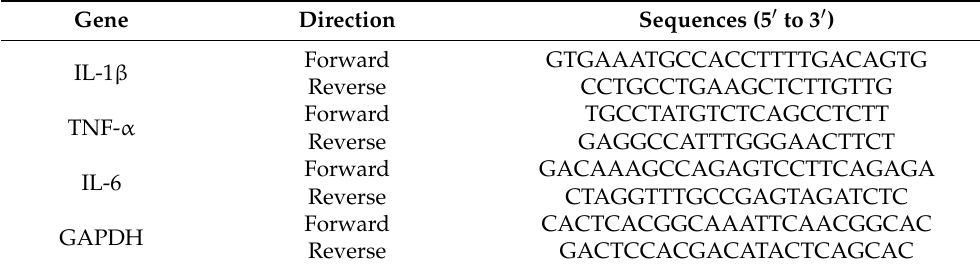
Table 1. Primers sequences for the analysis of mRNA prepared from RAW264.7 cells used in quantitative real-time